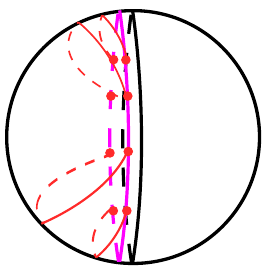
Figure 11 . dS 3 at time t = 0 is given by an S 2 with the bifurcate horizon as the great circle, represented in black. We regulate it into a stretched horizon, drawn in purple, on which we anchor extremal surfaces. These surfaces reach into the bulk, although as the stretched horizon approaches the bifurcate horizon the surfaces remain exactly on the horizon. The extremal surfaces anchored to the stretched horizon can be translated to finite time t > 0 using the static patch time-translation Killing vector, which puts them very close to the horizon at later